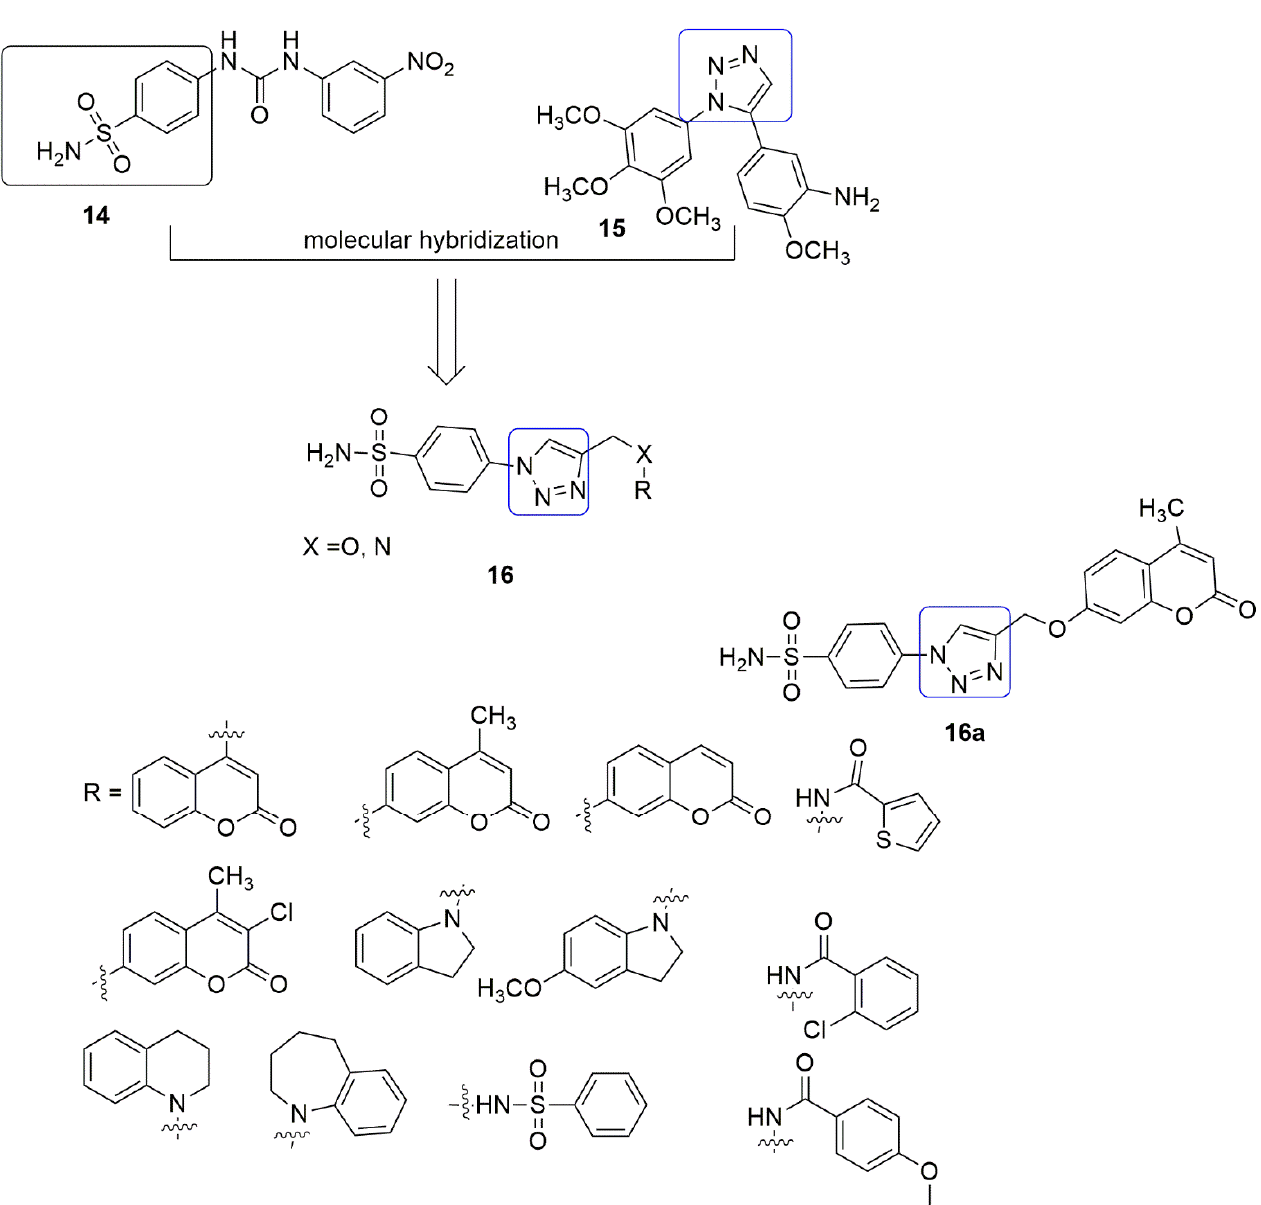
Figure 7. Chemical structures of sulfanilamide-1,2,3-triazole hybrids used against three selected human cancer cell lines (BGC-823, MGC-803, and